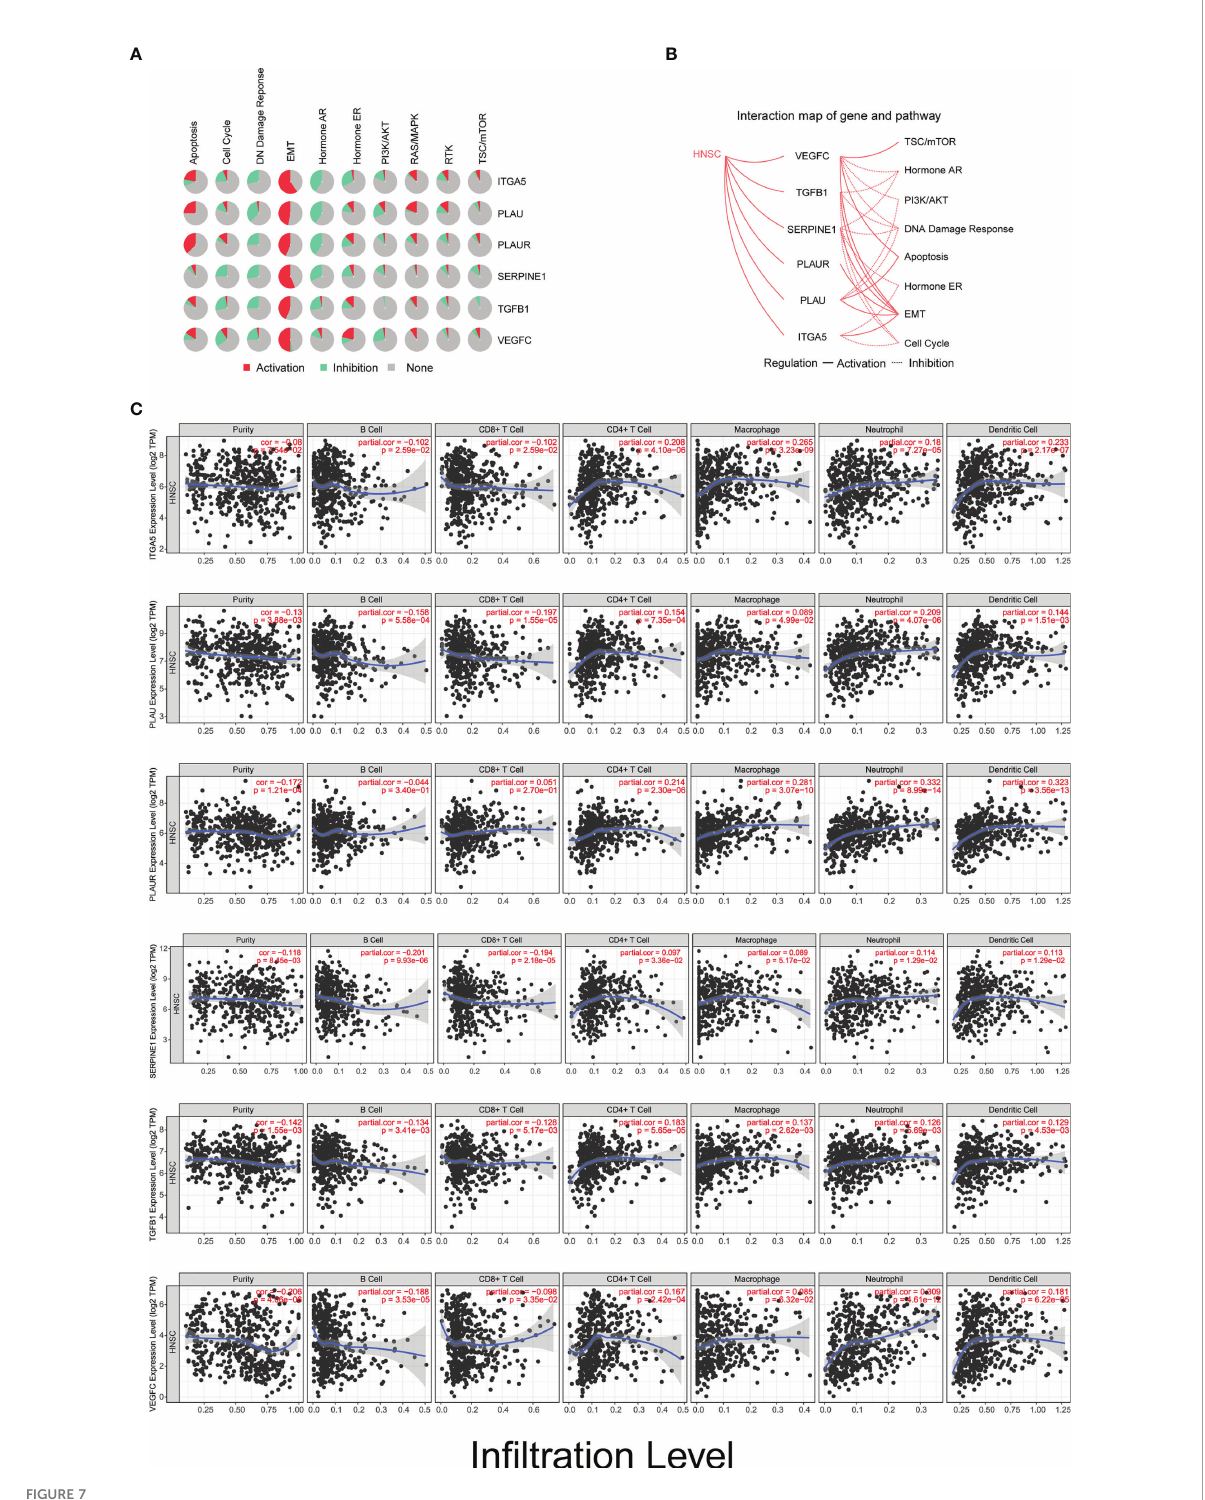
FIGURE 7 Biomarkers are involved in tumor microenvironment (TME) remodeling and immune in fi ltration in head and neck squamous cell carcinoma (HNSCC). (A) Activation/inhibition functionality of ITGA5 , PLAU , PLAUR , SERPINE1 , TGFB1 , and VEGFC on different biological signaling pathways. (B) Interaction map of ITGA5 , PLAU , PLAUR , SERPINE1 , TGFB1 , and VEGFC with potential biological signaling pathways in HNSCC. (C) Relationship between the in fi ltration levels of six types of immune cells and the expression level of the six biomarkers in patients with HNSCC ( n =